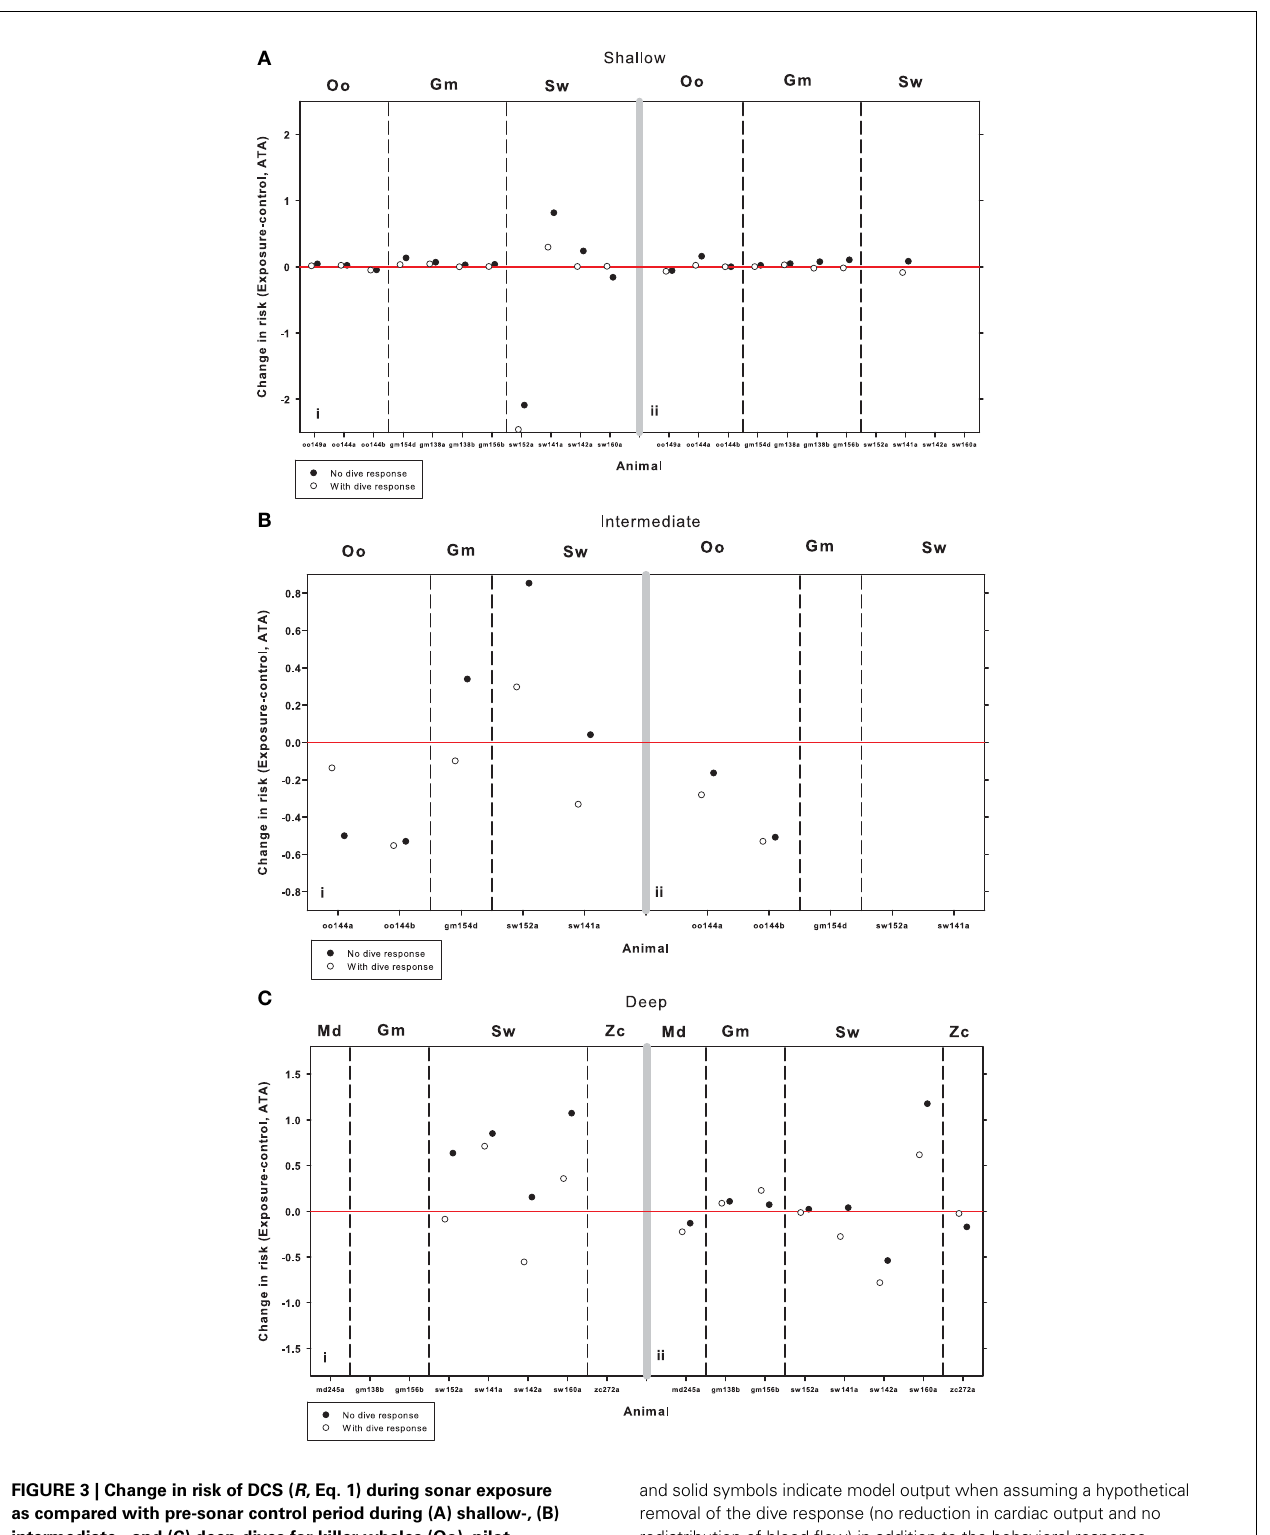
FIGURE 3 | Change in risk of DCS ( R , Eq. 1) during sonar exposure as compared with pre-sonar control period during (A) shallow-, (B) intermediate-, and (C) deep-dives for killer whales (Oo), pilot whales (Gm), and sperm whales (Sw). The left panels are LFAS exposures (i) and right panel MFAS exposures (ii) . Open symbols indicate model output assuming normal physiological dive response,